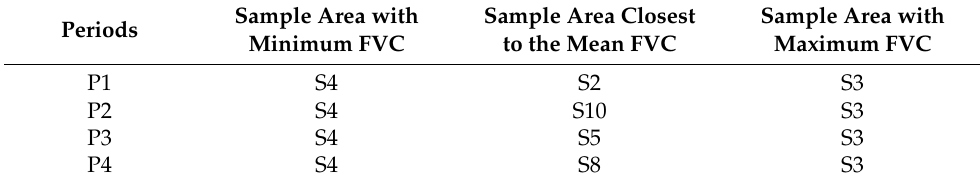
Table 4. Representative sample areas selected at